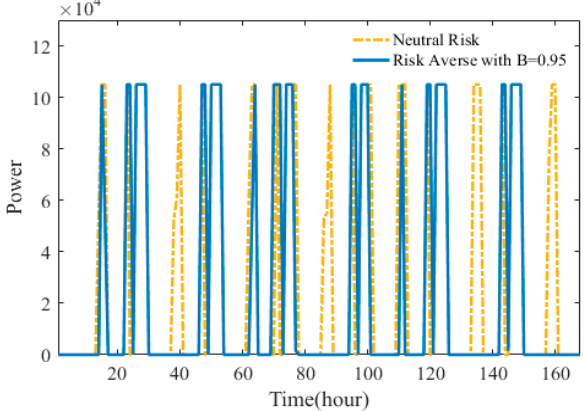
Figure 8. Transferred power from the grid to the demand side.